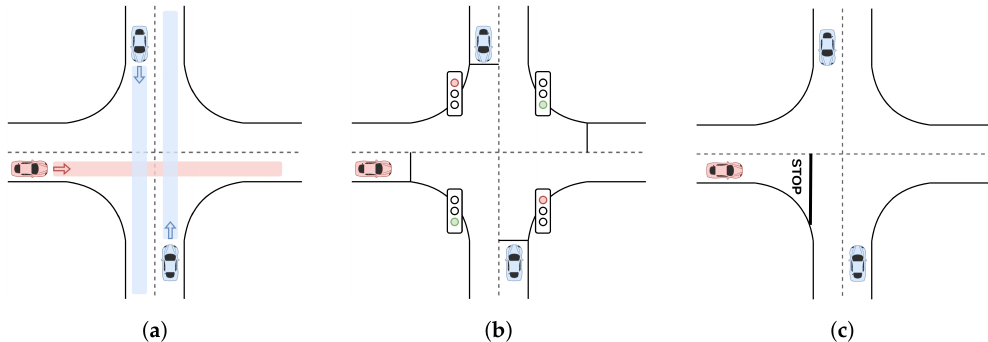
Figure 4. Definition of the three intersection scenarios. ( a ) Uncontrolled intersection scenario: The ego vehicle (red) follows the red trajectory and the adversaries (blue) follow the blue trajectory. ( b ) Traffic light intersection scenario: The ego vehicle (red) has a green light while the adversaries (blue) have a red light. ( c ) Stop intersection scenario: The ego vehicle (red) has a stop signal while the adversaries (blue) can freely cross the intersection.